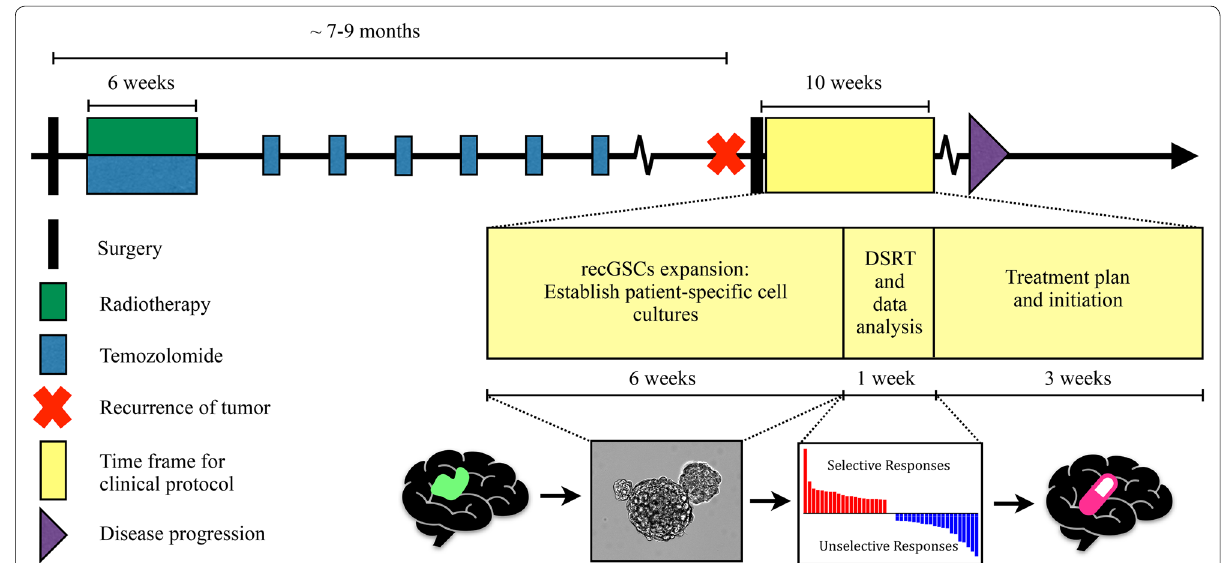
Fig. 1 Course of the disease and time frame for clinical protocol. Glioblastoma patients typically undergo surgery followed by combined radio‑ and chemotherapy for 6 weeks and thereafter monthly adjuvant chemotherapy. Despite this multimodal treatment the disease almost invariably recurs within 9 months. The time frame for this clinical protocol was defined as 10 weeks following surgery for recurrent GBM, which included expansion of individualized GSC cultures for 6 weeks, automated high‑throughput drug screening and data analysis for 1 weeks and scheduling a treatment plan and initiation within 3